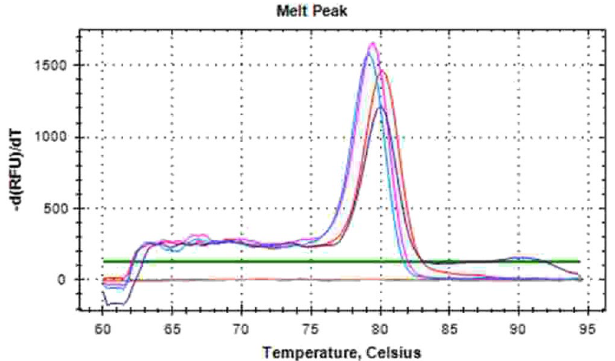
Figure 1. Melting curve results from ZKIR region detection obtained after 40 cycles using the ZKIR quantitative PCR system. DNA from two positive controls from K. pneumoniae strains (blue: UUA2239, violet: UUA2016). DNA extracted from patients’ buboes is in pink for PP2 and in red for PP8. Orange color corresponds to negative control.